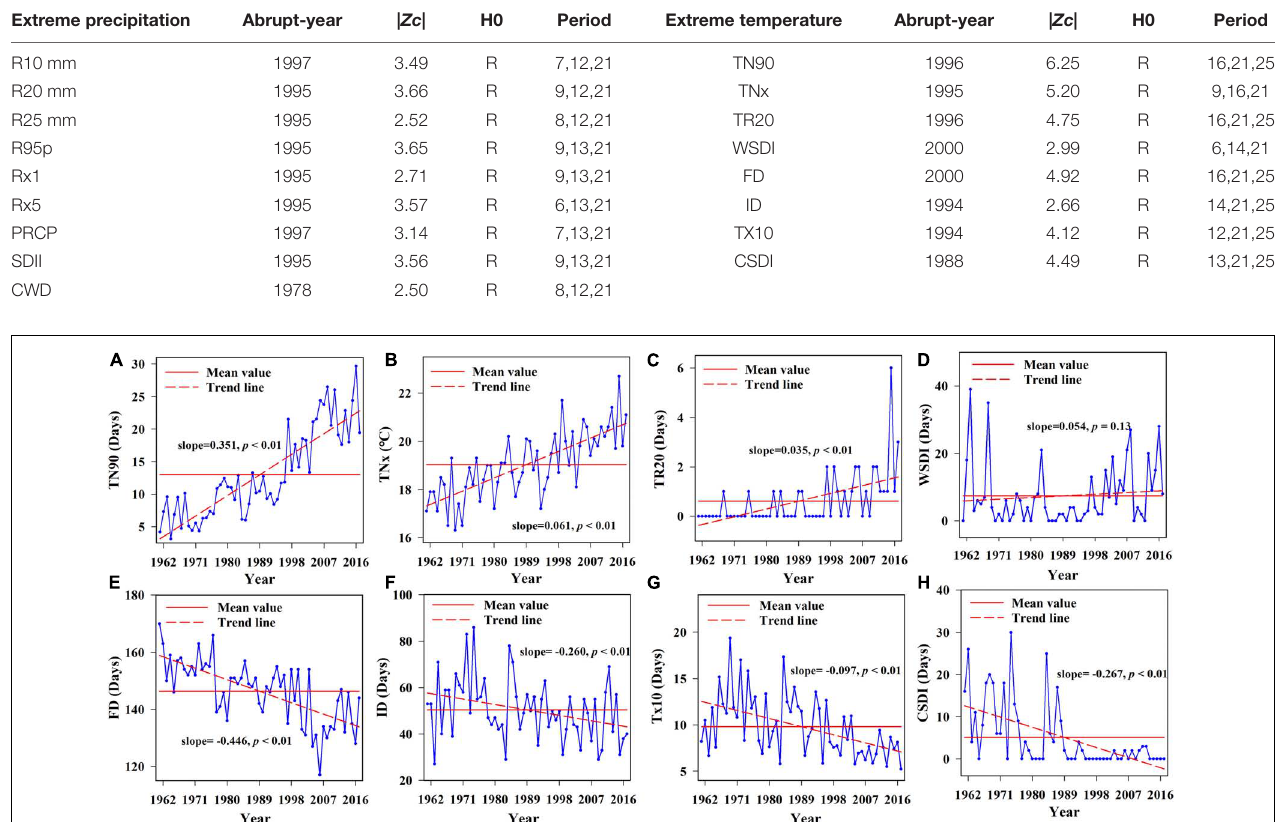
FIGURE 4 | Linear trend charts of annual extreme temperature indices during 1961–2017. (A) linear trend chart of warm nights, (B) linear trend chart of monthly maximum value of min temperature, (C) linear trend chart of hot nights, (D) linear trend chart of warm spell duration indicator, (E) linear trend chart of frost days, (F) linear trend chart of icing days, (G) linear trend chart of cold days, and (H) linear trend chart of Cold spell duration indicator.